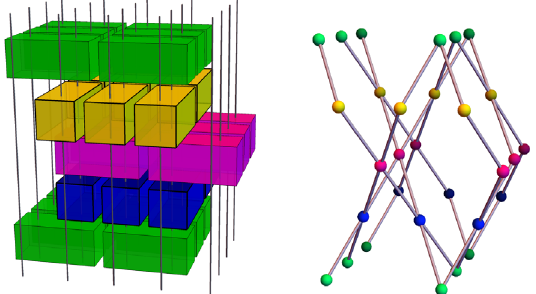
FIG. 16. A 2 þ 1 D analogue of the correspondence in Fig. 4. Left diagram: A simple choice of circuit geometry in 2 þ 1 D. Some unitaries (bricks) are hidden in the figure, so as to expose just six in each layer. Right diagram: Each unitary corresponds to a node of the four-coordinated lattice shown. Measurements break bonds of this lattice. The minimal cut (not shown) is a two-dimensional sheet whose cost is the number of unbroken bonds it